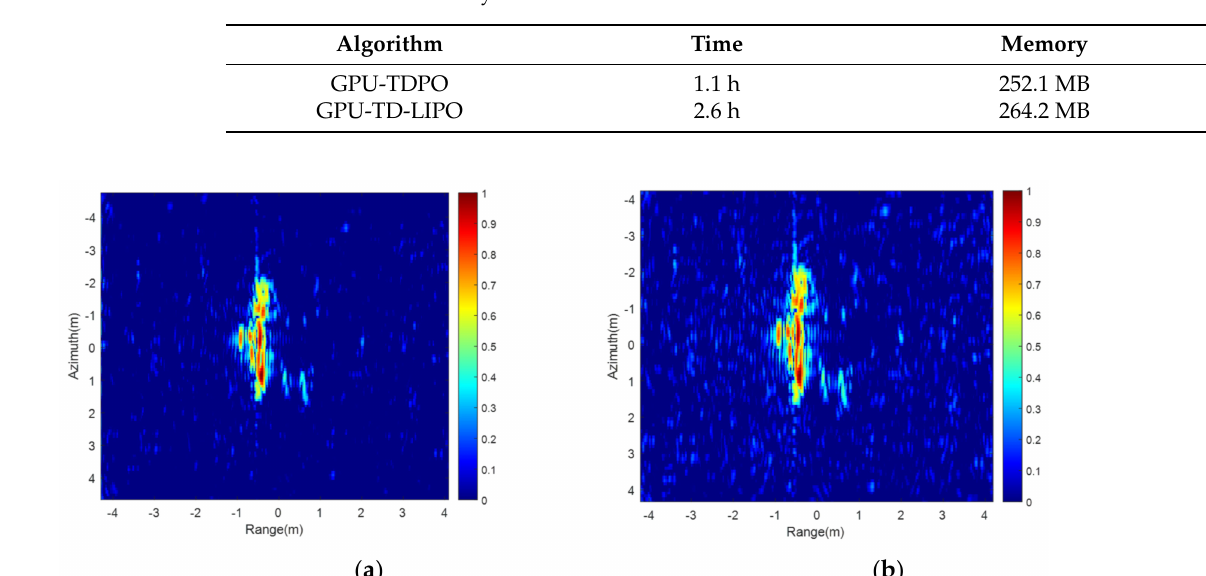
Figure 21. Normalized ISAR images of the composite model under different methods. ( a ) TDPO; ( b ) TD −